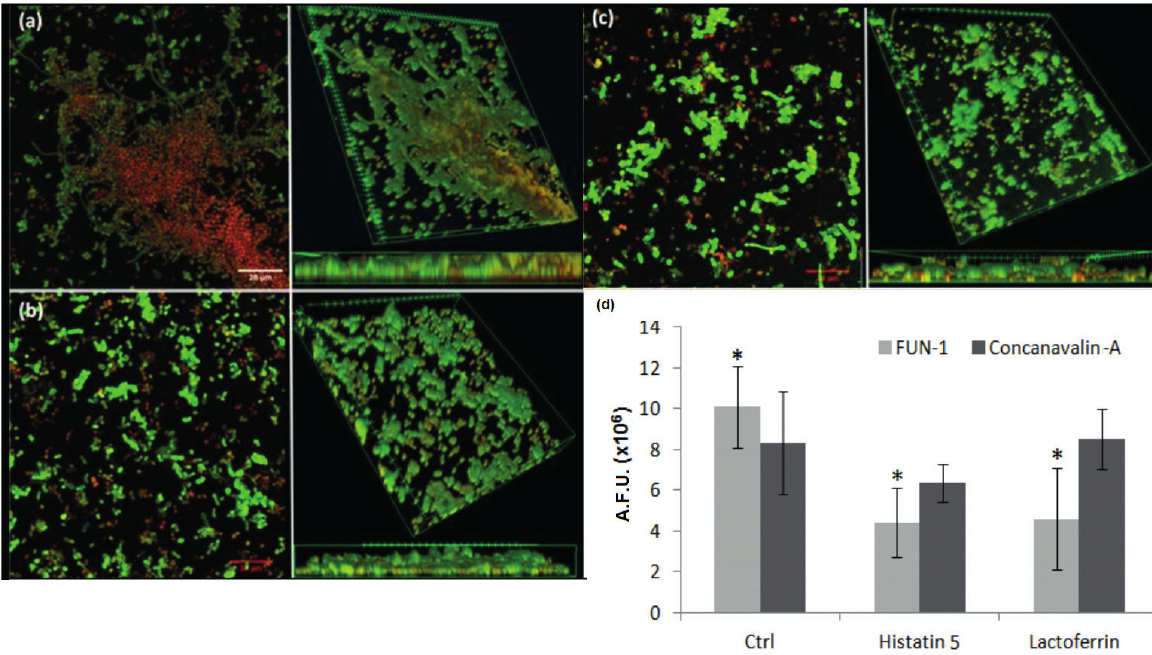
Figure 2 - CLSM in front view (right side) and 3D reconstruction (left side), showing the topography of fluconazole-resistant C. albicans biofilms. Biofilms were built for 48 h in absence of the compounds ( a ), in presence of histatin 5 at 150 µg/mL ( b ) and in presence of human lactoferrin at 500 µg/mL ( c ). Biofilms were stained with FUN-1, that stains the cytoplasm of metabolic active cells, and ConA-Alexa Fluor, that stains extracellular matrix. Quantitative analysis of arbitrary fluorescence units (A.F.U.) emmited by FUN-1 and Con-A alexa fluor 488 transmitted by fluconazole-resistant C. albicans clinical isolate biofilms that were formed for 48 h in presence of histatin 5 at 150 µg/mL or human lactoferrin at 500 µg/mL. *p < 0.05 ( d